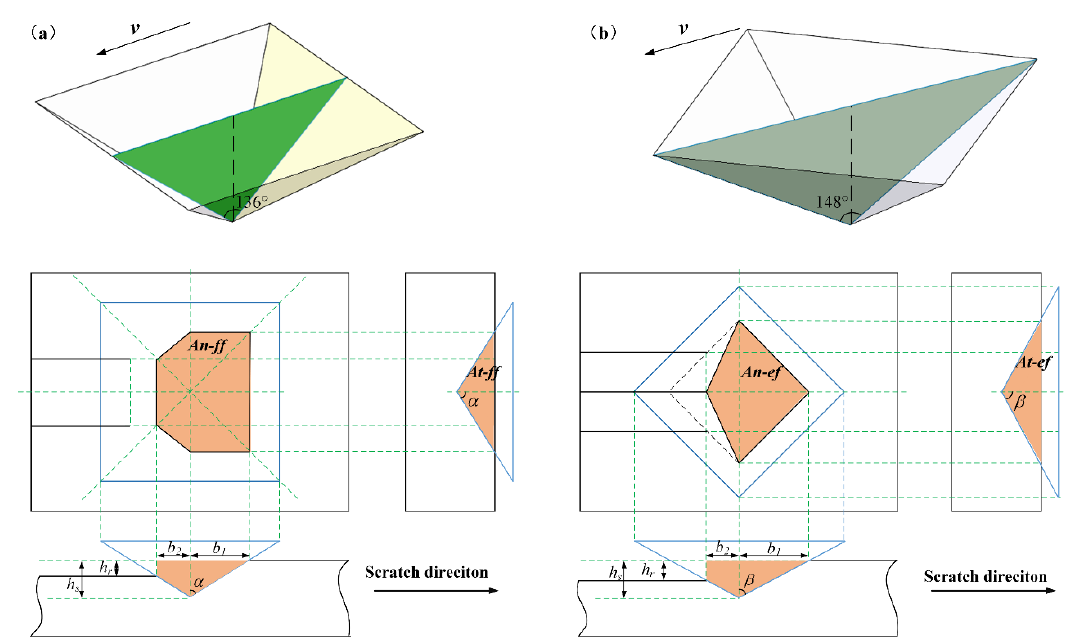
Figure 2. Projected areas of the interface for Vickers indenter tip with respect to different scratch directions: ( a ) face-forward; ( b ) edge-forward.